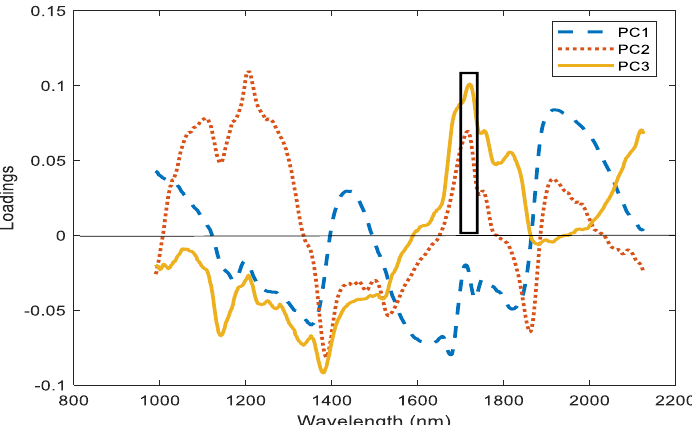
Figure 7. Spectral loadings of Principal Component Analysis of the spectrum of 2016 and 2017 seasons.